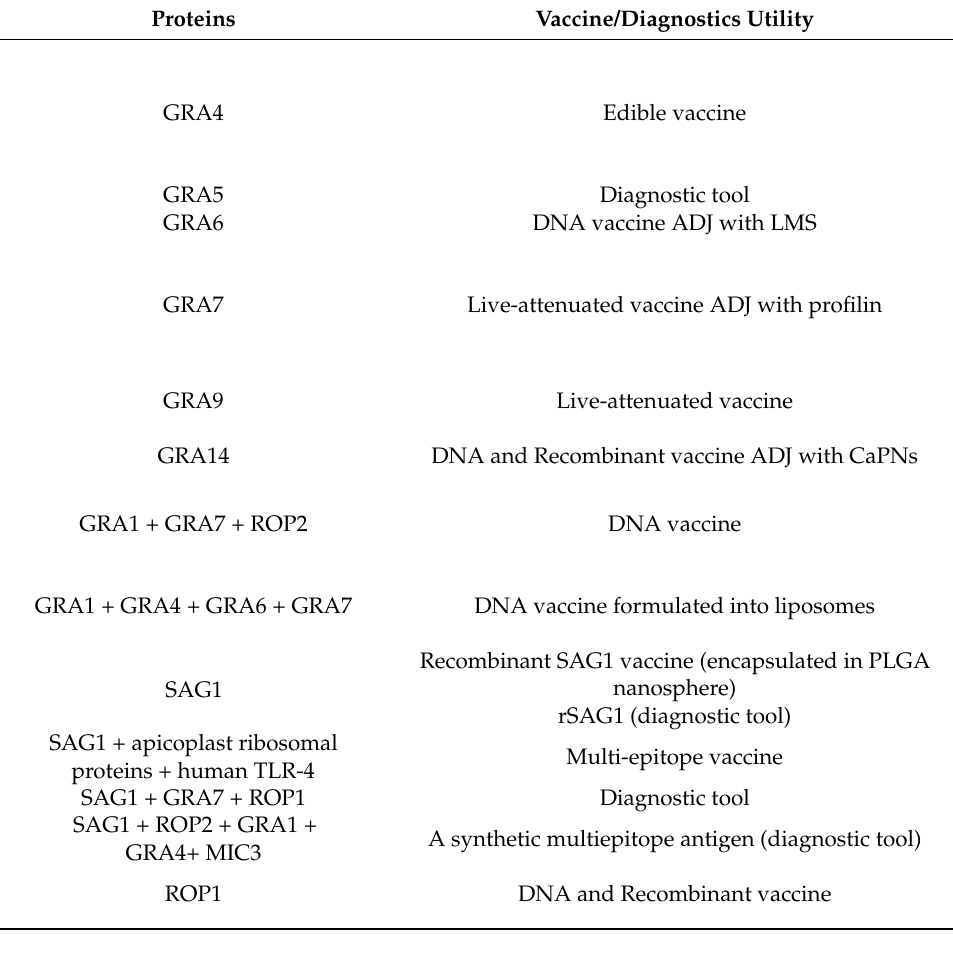
Table 2. Potential stage-specific vaccine and diagnostic candidates in